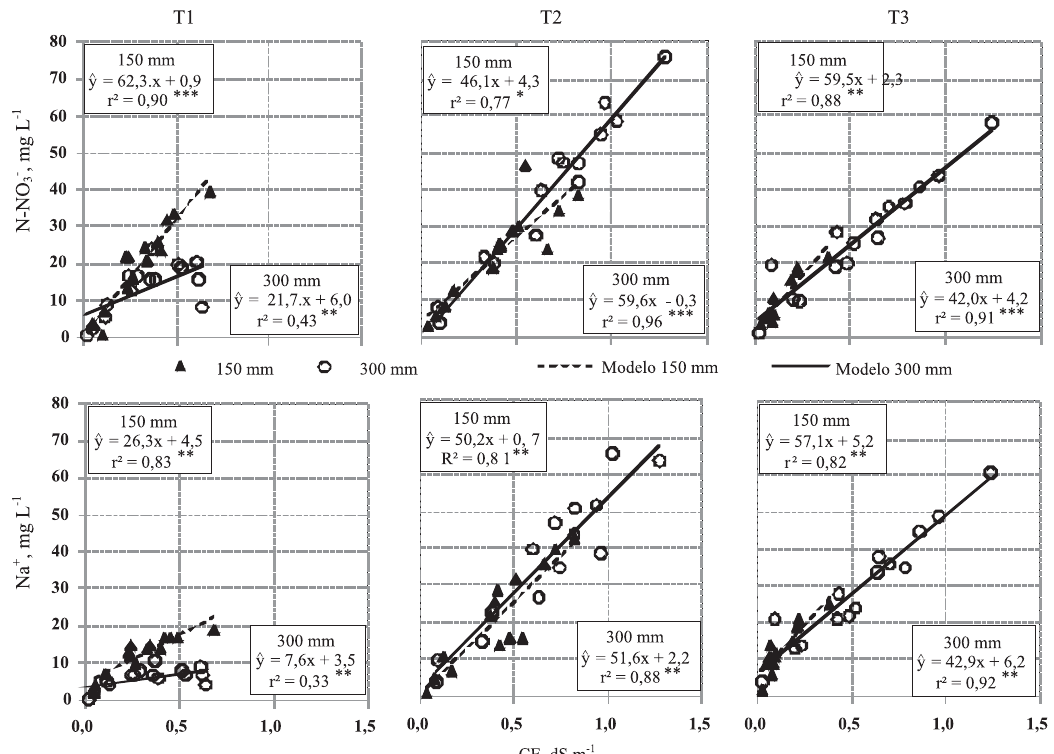
Figura 3. Relação entre Na, NO 3- e condutividade elétrica (CE) na solução do solo após aplicação de 150